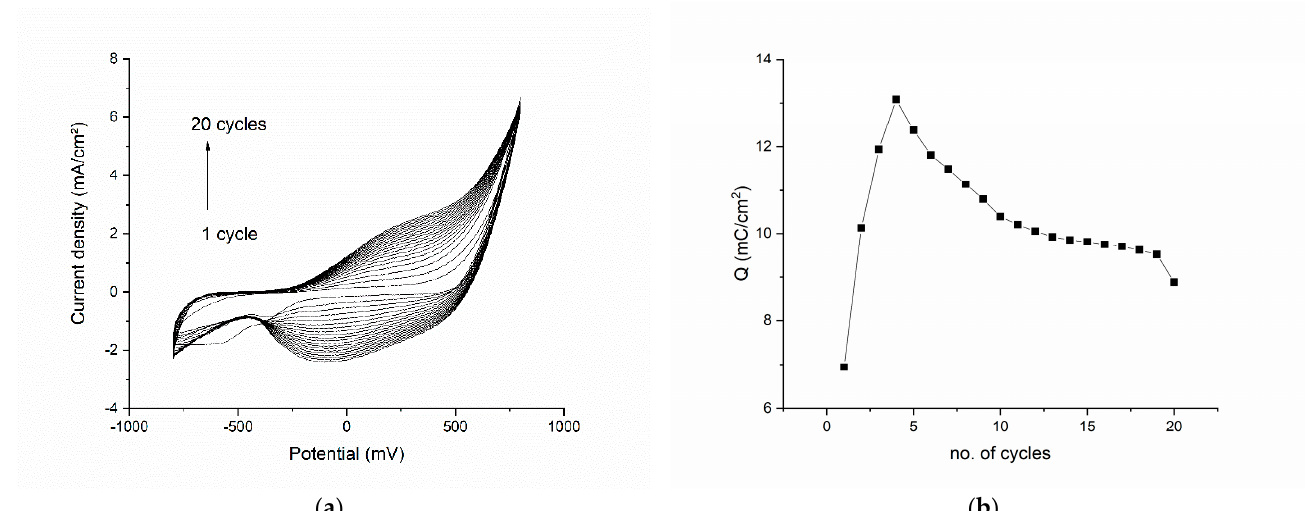
Figure 1. Electropolymerization results for the graphene–pyrrole composite: ( a ) the voltammogram of each of the 20 cycles of the polymerization procedure; ( b ) the total charge exchanged in the polymerization process as function of the number of